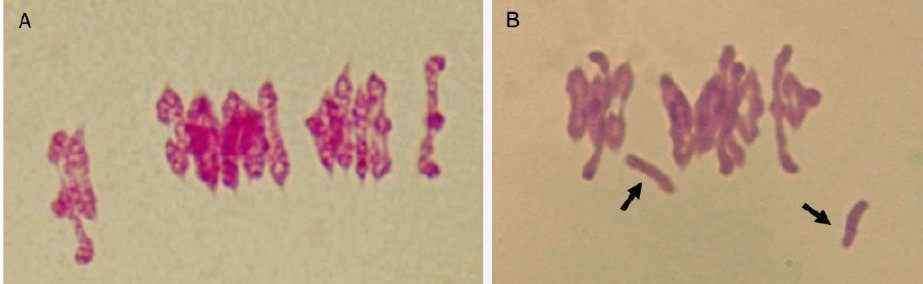
Figure 2. Cells of T. turgidum at metaphase I. ( A ) 12 ring bivalents and two rod bivalents (26 bound arms). ( B ) Nine ring bivalents, four rod bivalents and two univalents (arrowed) (22 bound arms).